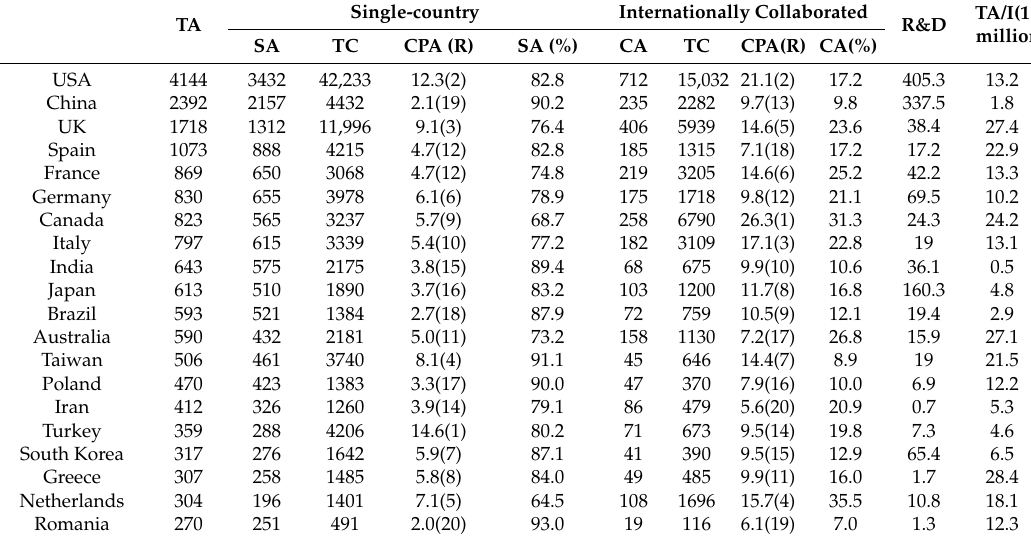
Figure 4. Relation between geographic distribution of authors and investment on R and D. Table 4. Twenty most productive countries/territories in artificial intelligence research.